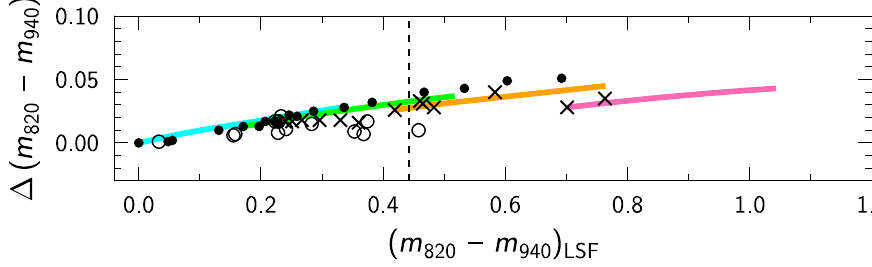
Fig. 10e. The same as in Figure 10a but for the color index m 820 – m 875 .